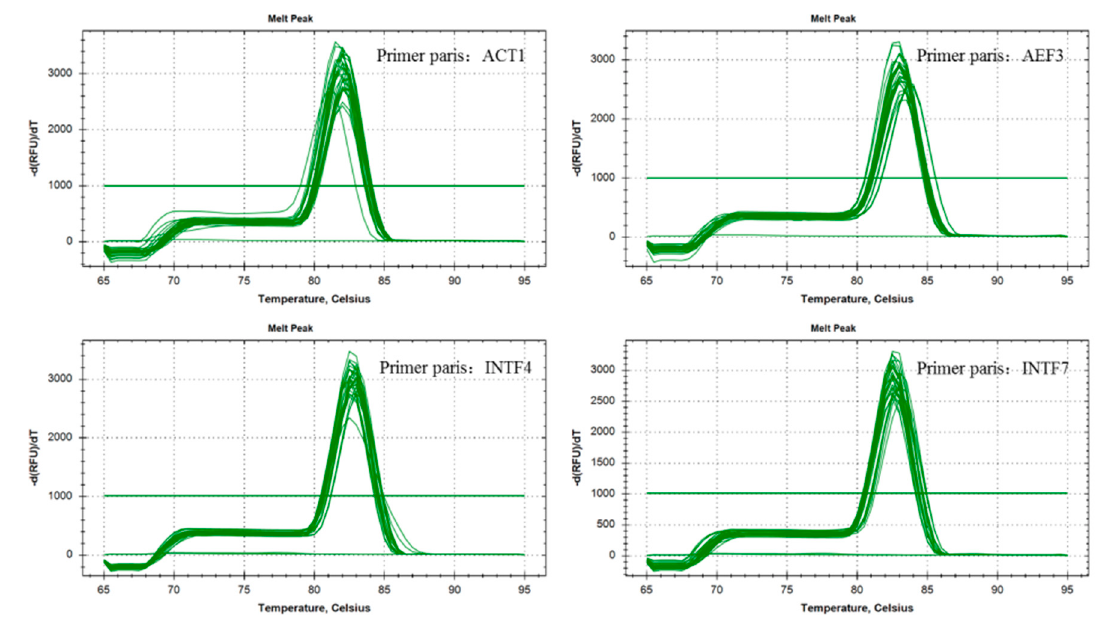
Figure 3 Amplification and dissolution curves of selected primers among ten different morel species.